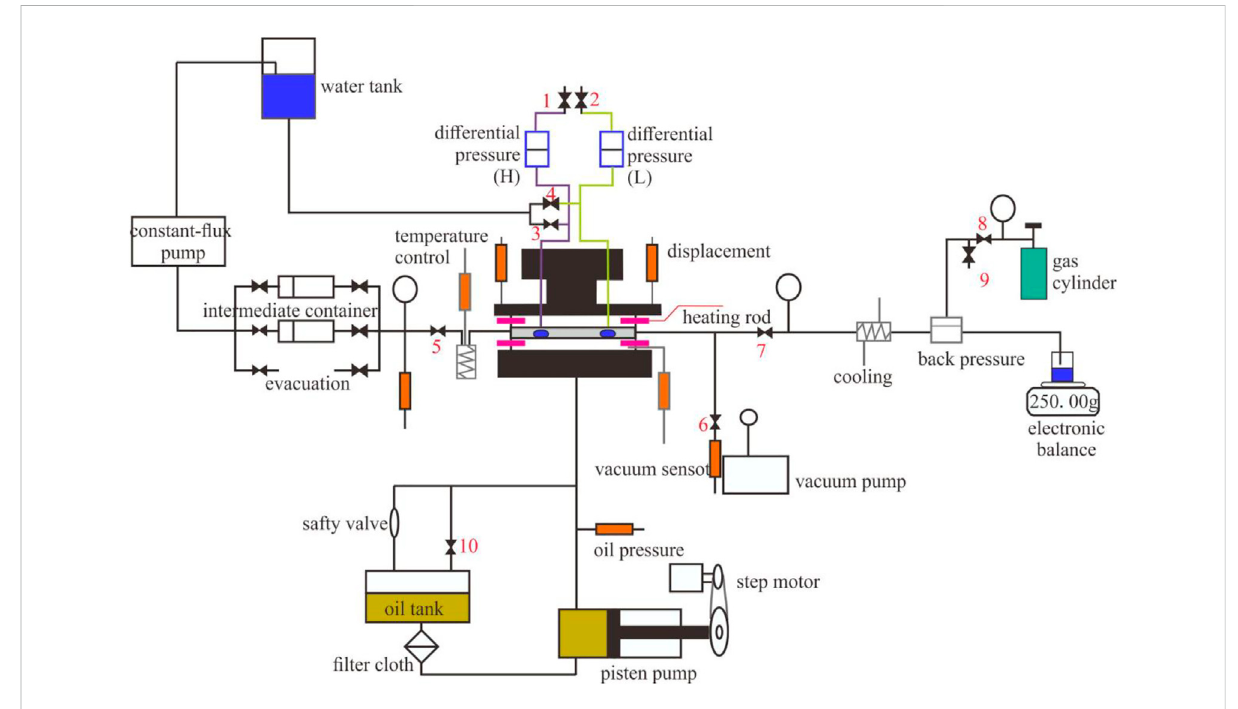
FIGURE 5 Schematic diagram of conductivity experiment